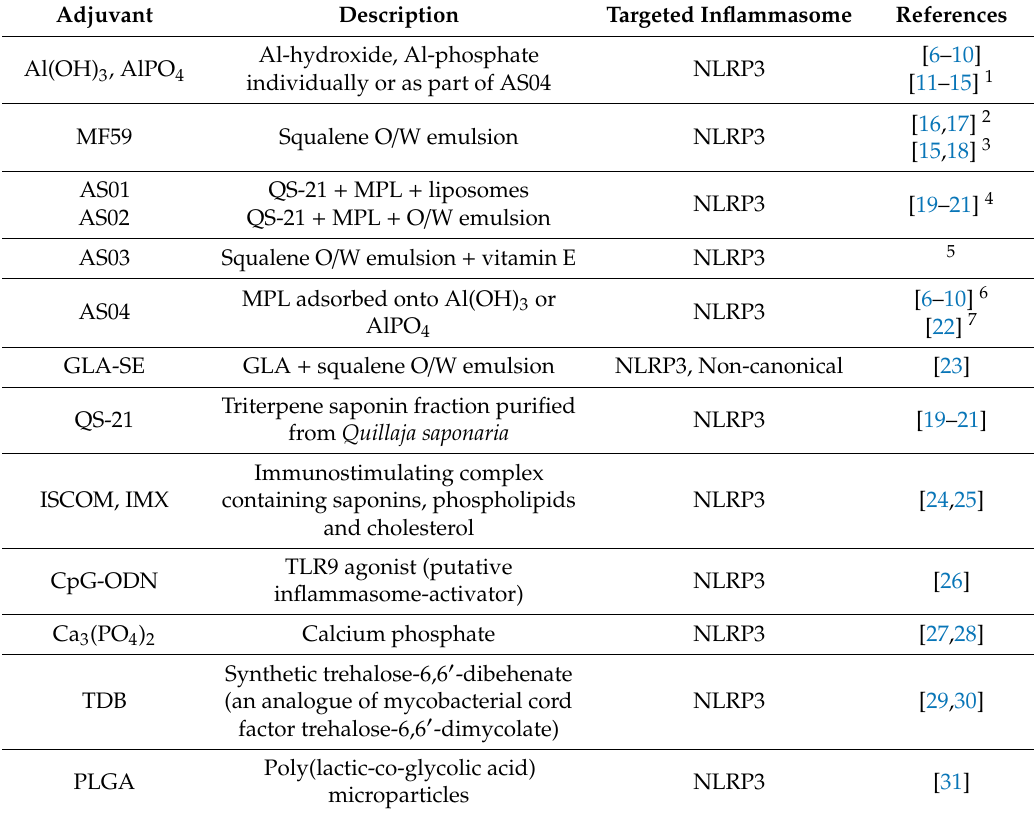
Table 1. Overview of inflammasome-activating